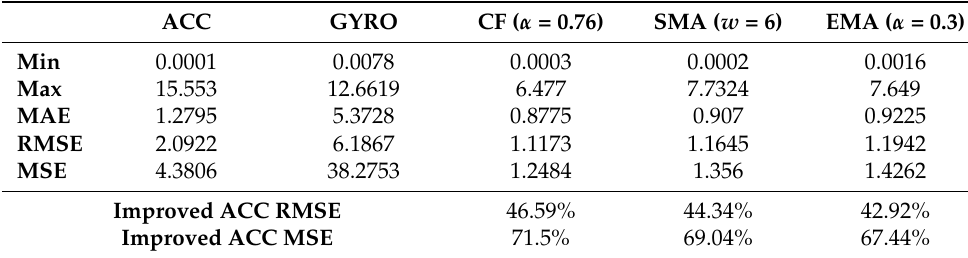
Table 1. Evaluation metrics of the applied filters in degrees.